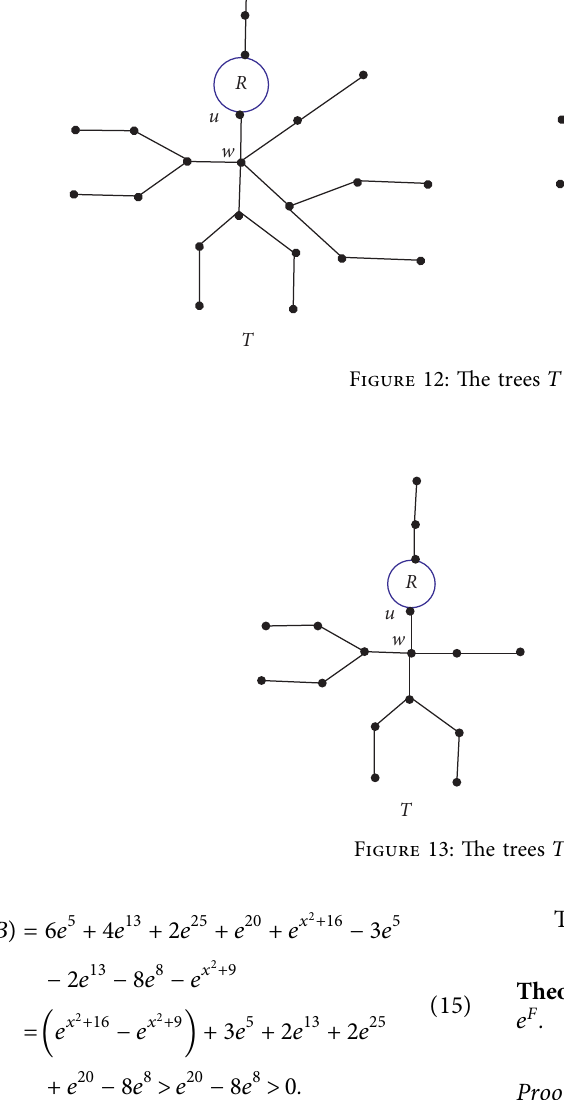
Figure 12: The trees T and T